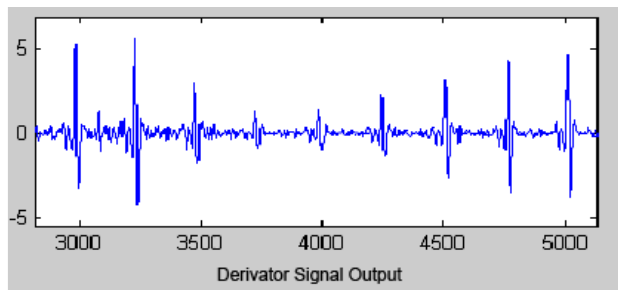
Figure 5. The derivative function output signal.